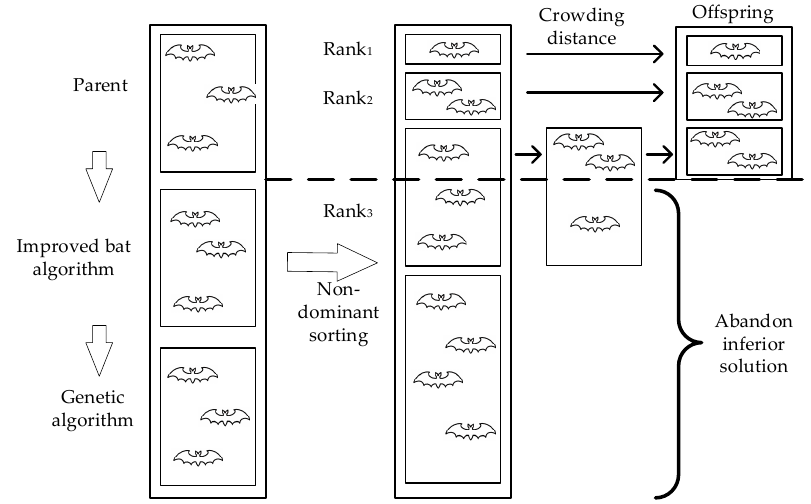
Figure 3. The main idea of elite strategy.